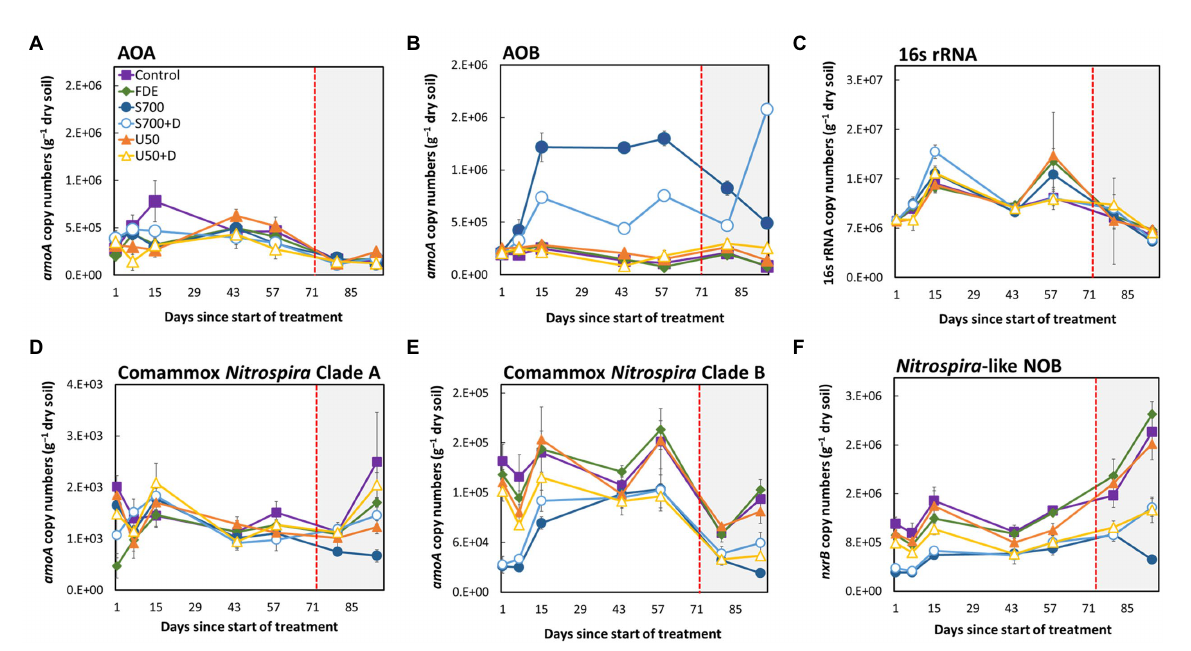
FIGURE 2 Microbial population dynamics of the 94-days microcosm study. The amoA gene abundance of: AOA (A) , AOB (B) , 16S rRNA (total bacteria) (C) , comammox Nitrospira Clade A (D) , comammox Nitrospira Clade B (E) , and Nitrospira -like NOB (F) . The unshaded area (Day 1–72) indicates soil moisture content at approximately 33%, and the shaded area (Day 73–94) indicates soil moisture at approximately 42%. Error bars indicate the standard error of the mean for all sample replicates ( n =